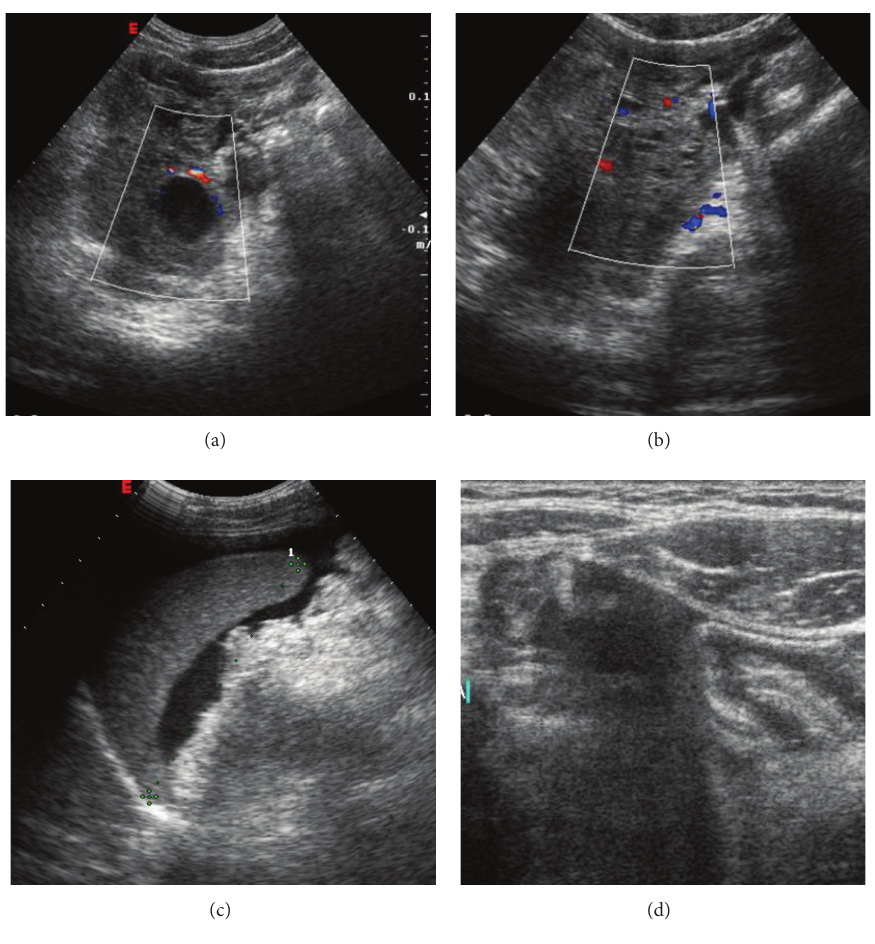
Figure 1: Transabdominal US shows on the right adnexal area a regular cyst with internal echoes and peripheral vascularization on Doppler evaluation (a). Free fluid into the pouch of Douglas (b) and around the spleen (c). (d) Ultrasonographic scanning with linear probe shows free fluid containing low level echoes in the right iliac fossa. No signs of appendicitis are appreciable.